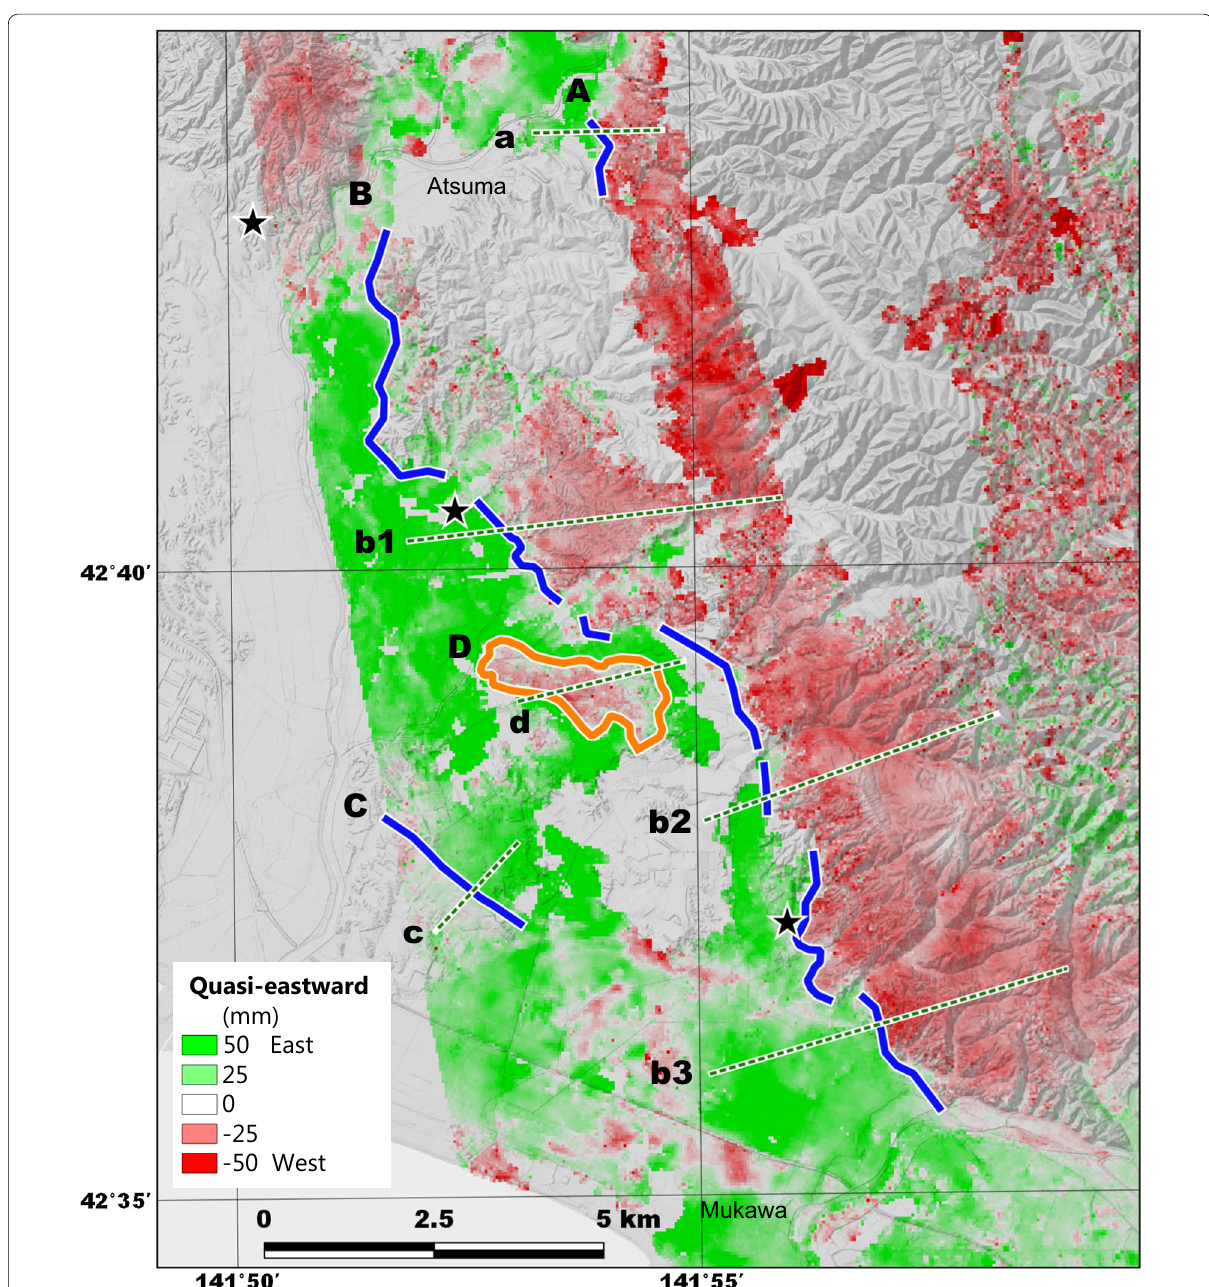
Fig. 6 Displacement map (2.5-D) for quasi-eastward direction synthesized from the SAR interferograms in Figs. 2 and 4. Blue lines (A, B, and C) show the linear surface displacements. The orange line (D) shows an independent surface displacement with a rounded pattern. Dashed lines (a, b1–3, c, and d) mark the cross sections shown in Fig. 7. Black stars indicate the positions of discontinuities in the basement identified by seismic exploration (Yokokura et al.